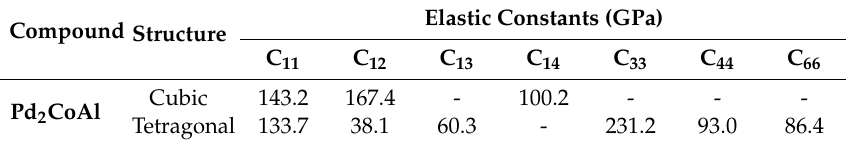
Table 2. The calculated various elastic constants (C ij ) for the full Heusler compound Pd 2 CoAl in both cubic and tetragonal